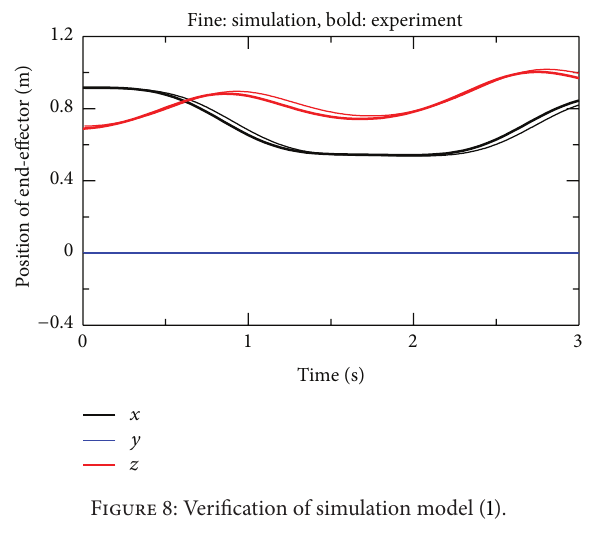
Figure 8: Verification of simulation model